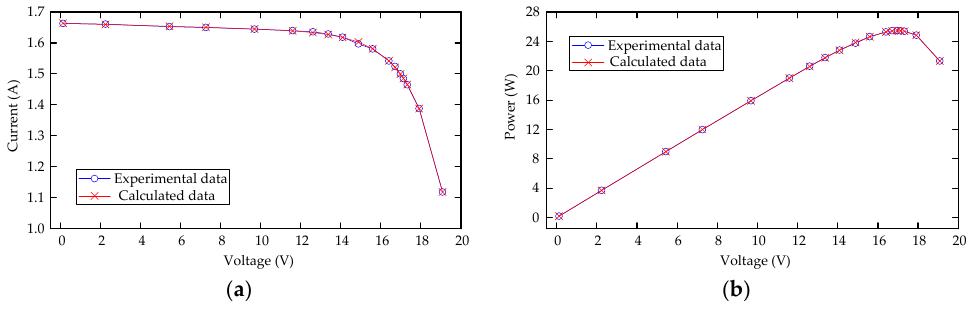
Figure 13. Comparisons between the experimental data and calculated data obtained by the proposed ImCSA for the PMM of monocrystalline STM6-40/36 panel: ( a ) I-V characteristics; ( b ) P-V characteristics.